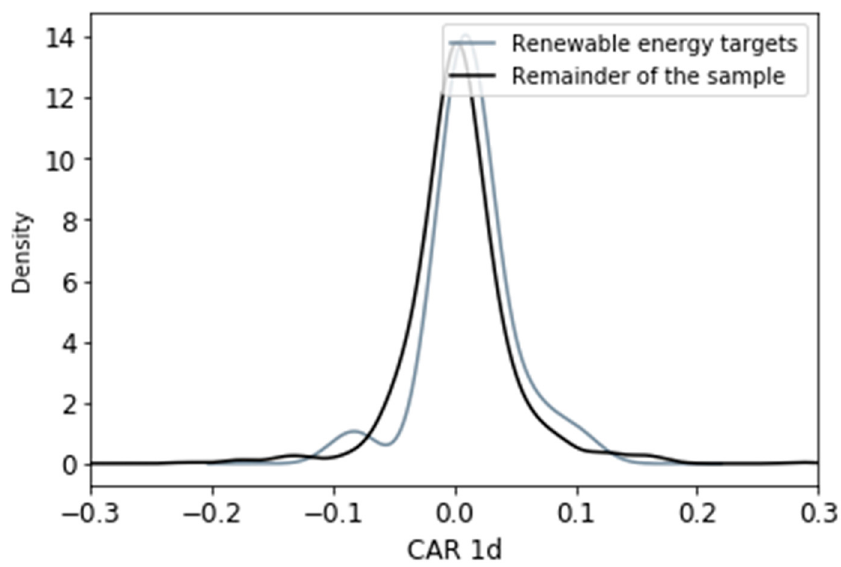
Figure 1. Comparison of cumulative post-deal returns (renewable energy targets vs. non-renewable energy targets). Table 7. Acquisition premia and post-completion returns—cross-sectional univariate Table 6. AR around transaction finalization for energy firms’ acquisitions.